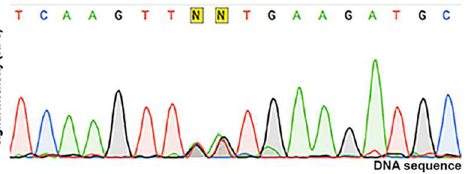
Fig 3. DNA sequencing electropherogram of the Tyr93 mutant library. The peak height is given in relativefluorescence units (RFU) and represents the signalintensity at each nucleotide, along the x axis. The identity of each nucleotide is automatically assigned(above each peak) when the signal is unequivocal, or is labelled‘N’ when more than one nucleotide provides a statistically significantsignal. The NDT degeneracy (25% each A/C/G/T; 33% A/G/T; T) is clearly